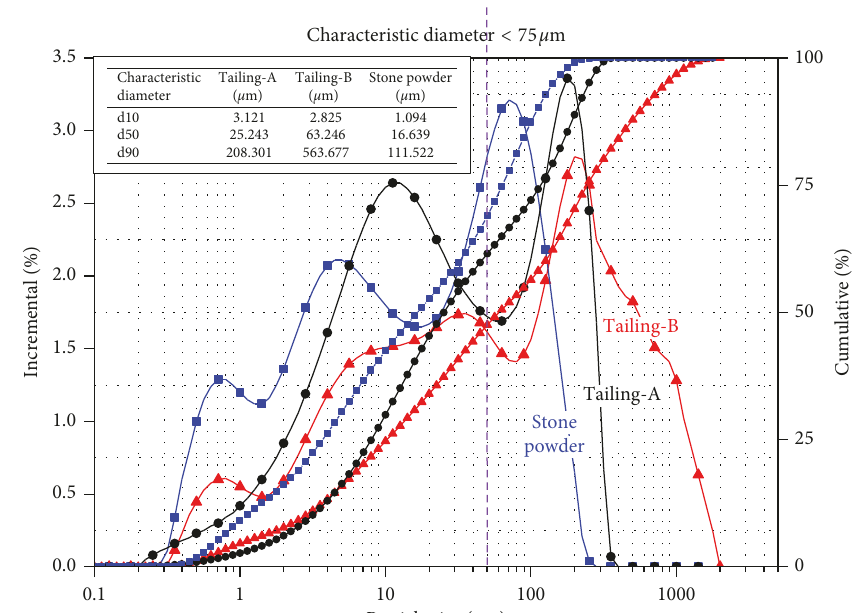
Figure 3: Particle-size distributions of tailings and stone powder (including incremental and cumulative